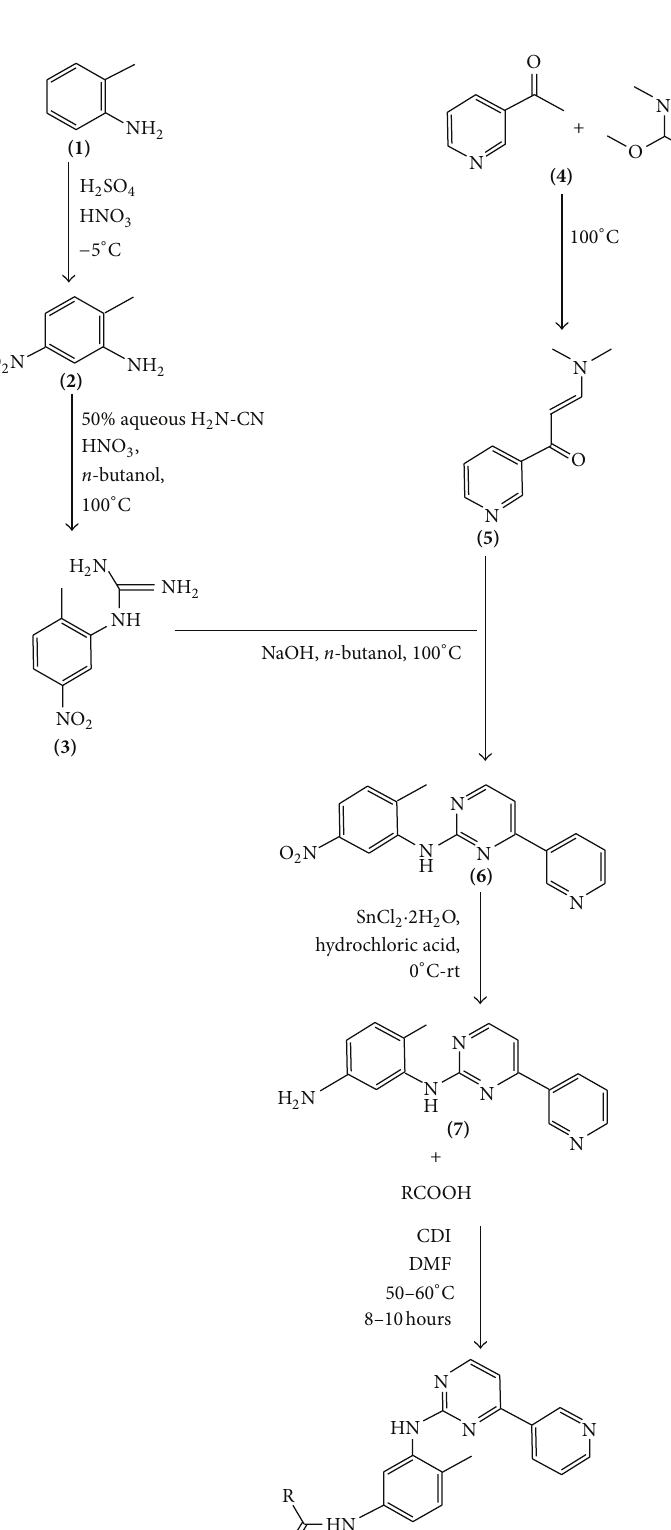
Figure 1: General synthesis of